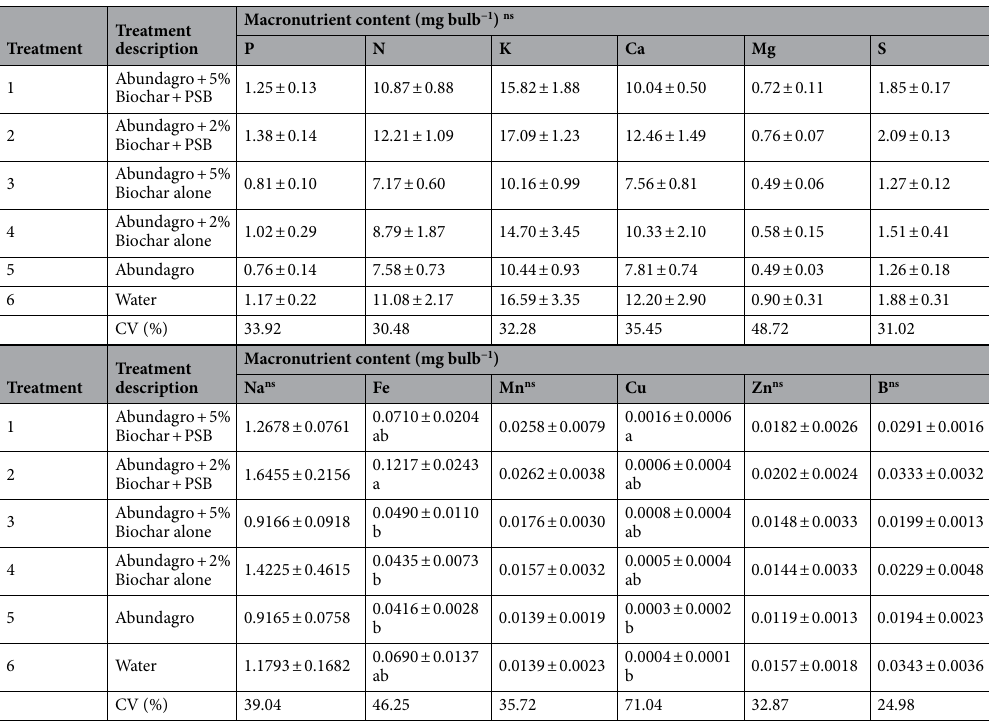
Table 4. Macronutrient and micronutrient content of A. cepa L., bulb. Letters show heterogeneous groups based on Tukey’s test and indicate significant differences among treatments ( p < 0.05). ns = no significant difference ( p > 0.05). CV = coefficient of